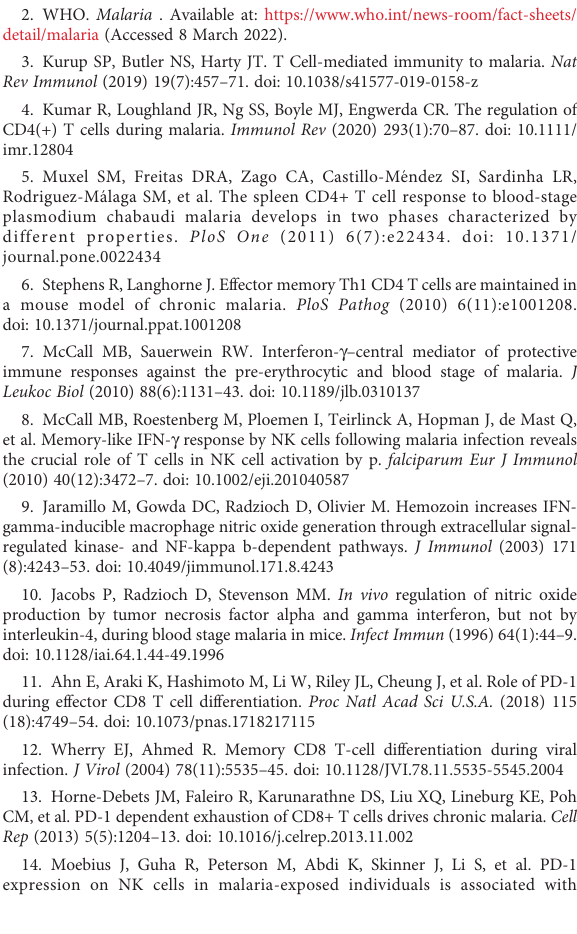
The information for the differentially expressed genes in microarray transcriptome sequencing data.